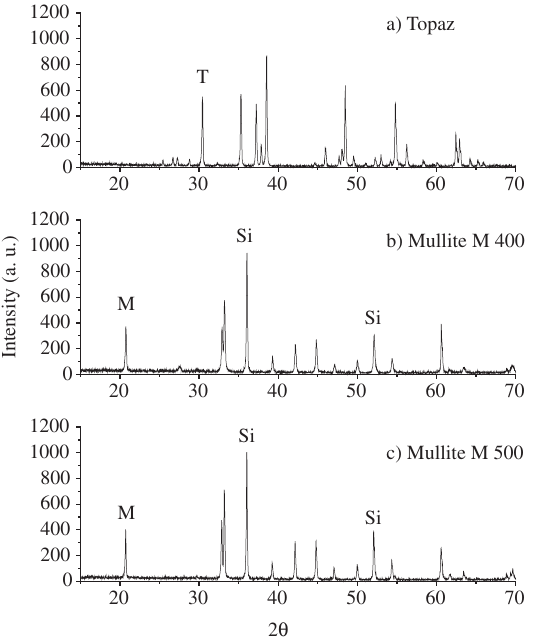
Figure 3. Powder XRD patterns for a) colorless topaz, b) M400 sample, and c) M500 sample. Table 2. Unit cell parameters and unit cell volume of mullite. Samples Cell parameters (Å) Volume